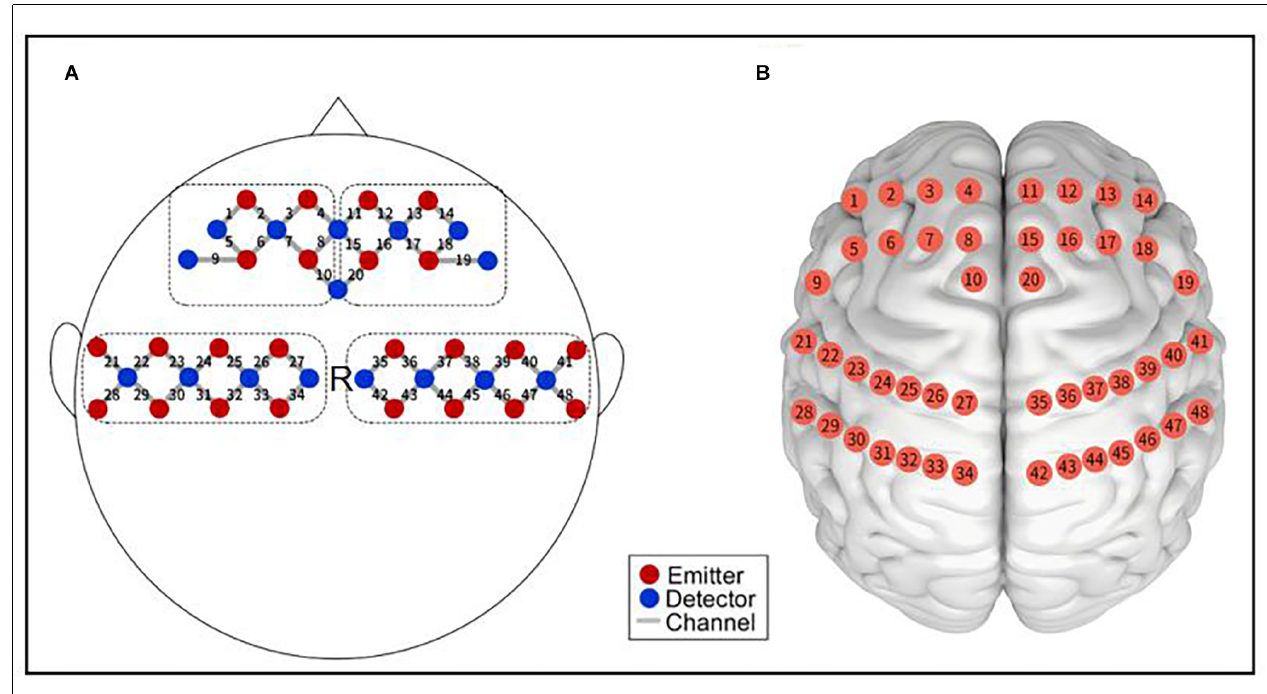
FIGURE 2 | Functional near-infrared spectroscopy measurement. (A) Schematic of the imaging pad; 24 emitters (red dots) and 24 detectors (blue dots) were symmetrically placed on the bilateral hemispheres for 48 measurement channels (gray lines), allowing for the measurement of prefrontal and sensorimotor cortices. R was placed in Cz of the international 10–20 system. (B) The anatomical position of each measurement